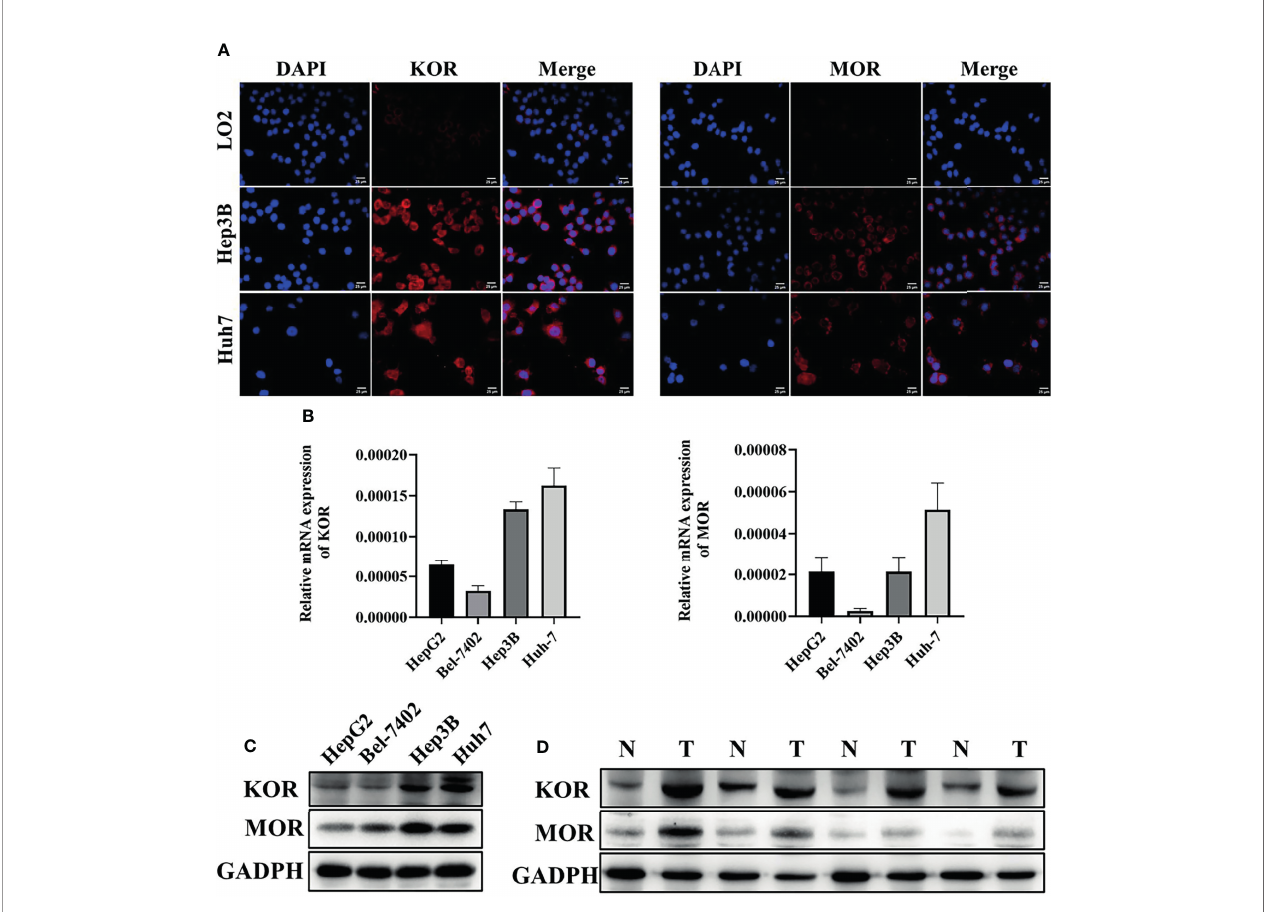
FIGURE 1 | The expression of KOR and MOR in HCC cell lines and human HCC tissues. (A) The expression of KOR and MOR were detected in LO2, Hep3B and Huh7 cells by immuno fl uorescent staining, scale bar, 25um. The expression of KOR and MOR was evaluated in 4 types of HCC cell lines (HepG2, Bel-7402, Hep3B and Huh-7) by RT-qPCR (B) and western blotting (C) . (D) In human HCC tissues, KOR and MOR were detected by western blotting, GADPH was used as an internal control. N, Non-tumor; T, Tumor. Values are presented as the mean ± standard deviation (n = 3). KOR, kappa opioid receptor; MOR, mu opioid receptor; GADPH, glyceraldehyde-3-phosphate